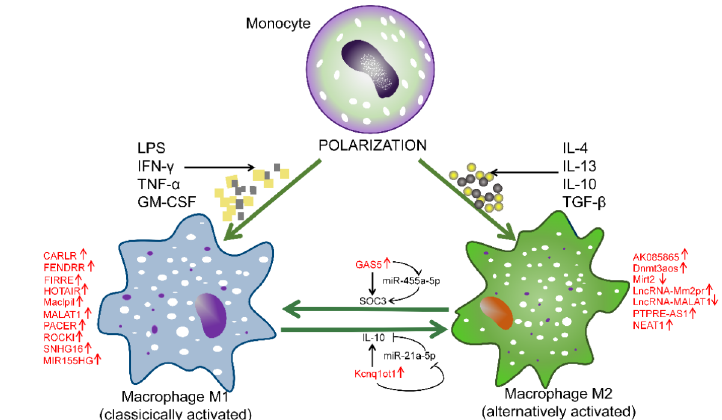
Figure 2. LncRNAs regulate the polarization of M1 and M2 macrophages. LncRNA-CARLR, CHRF, FENDRR, FIRRE, HOTAIR, H19, Maclpil, MALAT1, MIR155HG, PACER, ROCKI, GAS, and SNHG16 induce macrophage polarization into the M1 phenotype. LncRNA-AK085865, Dnmt3aos, PTPRE-AS1, Mm2pr, KCNQ1OT1, and NEAT1 induce macrophage polarization into the M2